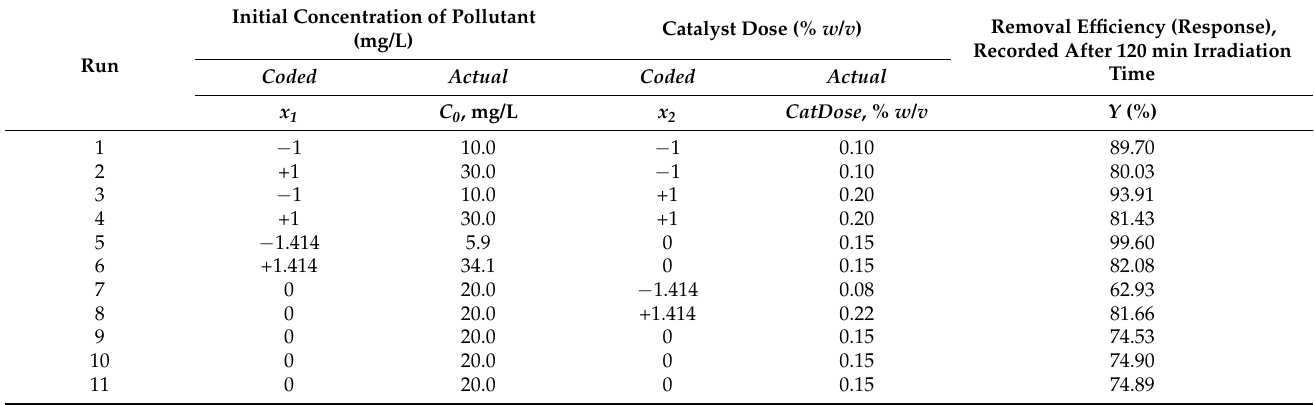
Table 3. Central composite design (rotatable type) used for experimentation of ciprofloxacin pho- todegradation in the presence of ZnO:Nd (0.1%)